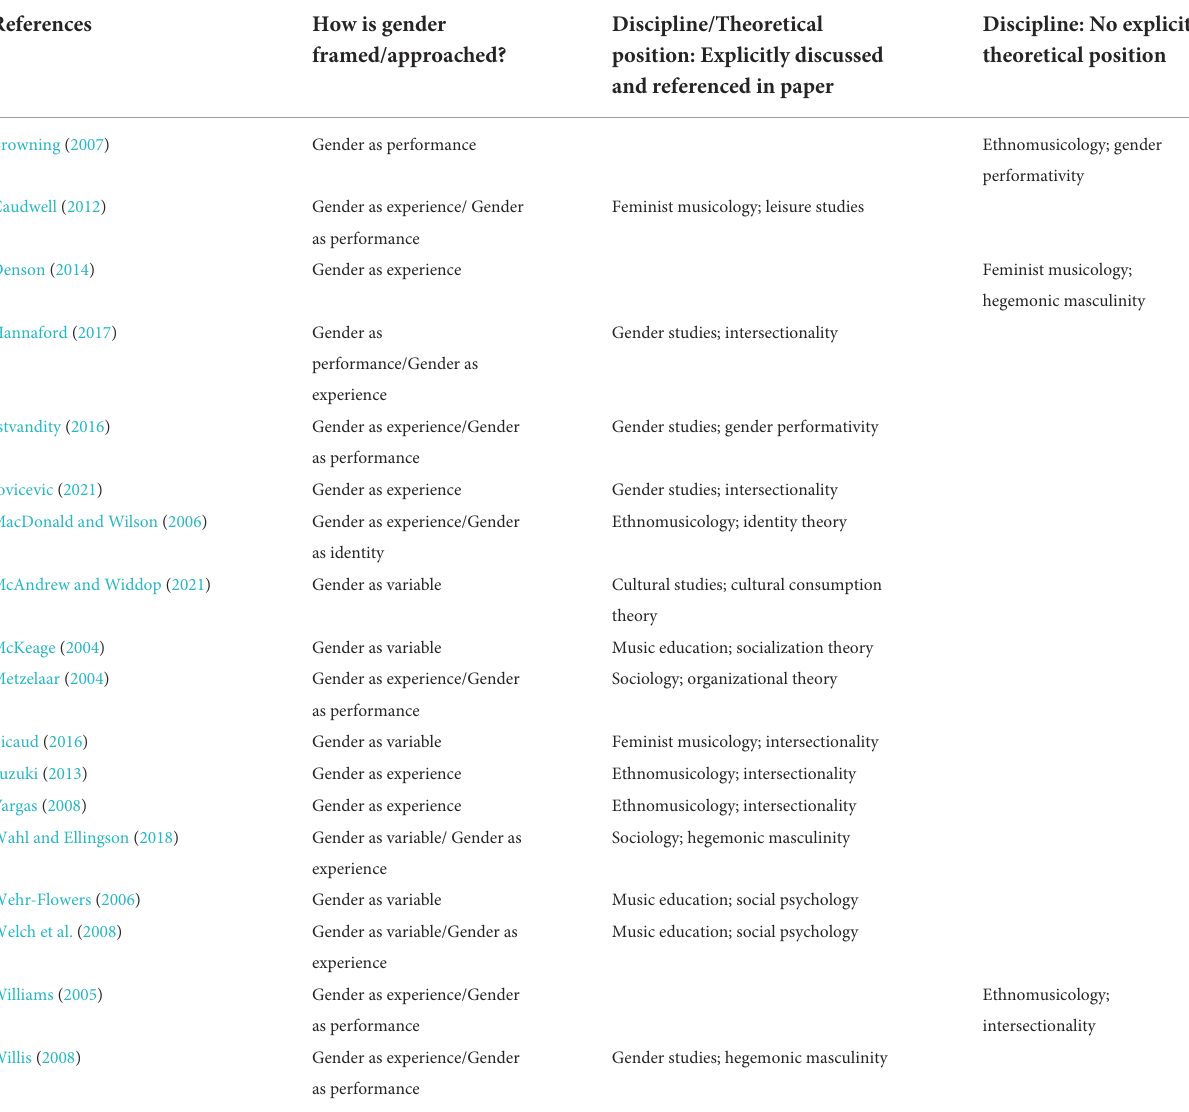
TABLE 7 Theoretical framework and framing of